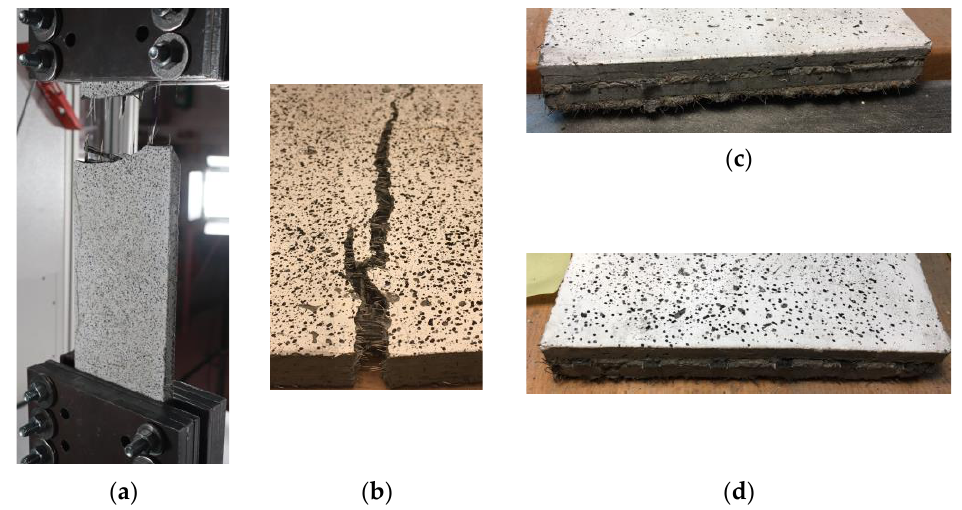
Figure 8. Failed specimens: ( a ) BP-1-A specimens, textile rupture; ( b ) main crack on specimen BPf-1-A and detail of the textile at the two ends of the specimen ( c , d ).